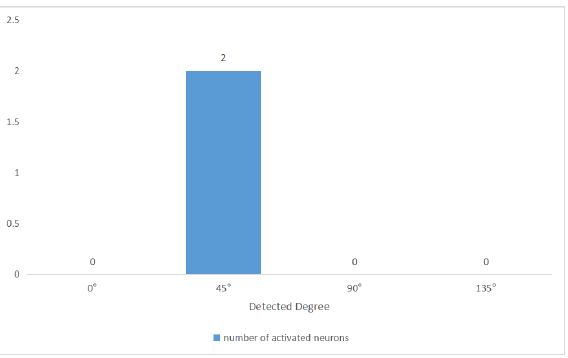
Figure 10. Activated neuron in Figure